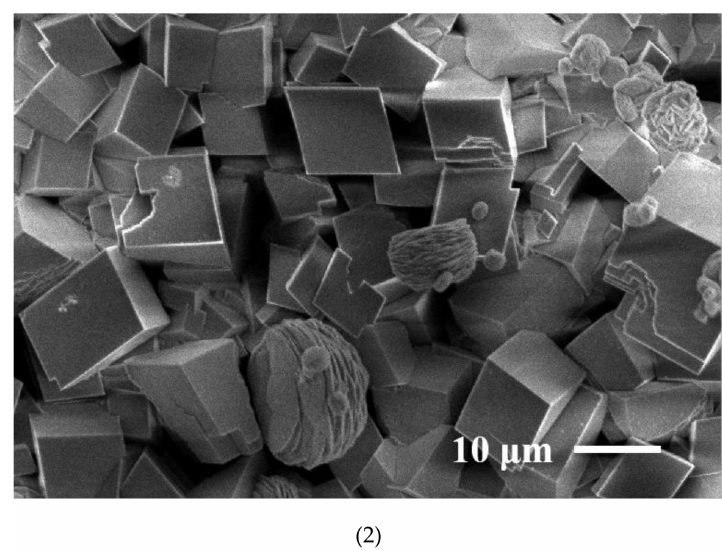
Figure 4. The morphology of CaCO 3 crystals generated on the cathode surface in the blank scaling solution, under di ff erent polarization potentials. ( 1 ) Polarization at − 1.0 V; ( 2 ) Polarization at − 1.5 V.